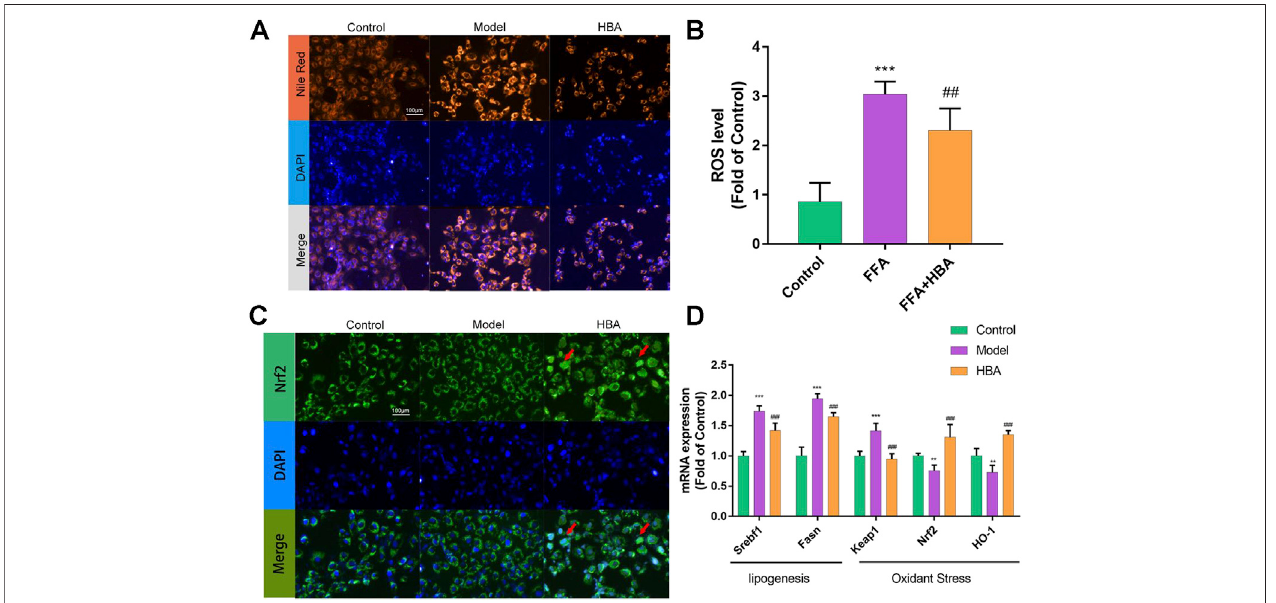
FIGURE5| TheeffectofHBAonFFA-inducedBRL-3Acell invitro (A) NileredstainingofBRL-3Acellsafter1 mmFFAwithandwithoutHBA(20 μ M)treatmenttoreveallipid level. (B) Measurement of ROS level in BRL-3A cells after 1 mm FFA with and without HBA (20 μ M) treatment. (C) Fluorescence image of FITC-conjugated secondary antibody stainingindicatesthelocationofNrf2(green),DAPIstainingindicatesthelocationofthenucleus(blue),andthemergedimagesshowthenuclearlocationofNrf2protein.Redarrows showtheHBA-inducedtranslocationofNrf2tothenucleus. (D) mRNAexpressionpro fi leofHBAonFFAinducedBRL-3Acellrelatedtolipogenesisandoxidantstress.Bar indicate means ± SD. ** p < 0.01*** p < 0.001 represent compared with the control; ## p < 0.01, ### p < 0.001 represent compared with Model. p < 0.05 was considered as statistically signi fi cant calculated by One-way ANOVA followed by Tukey ’ s test ( n (cid:1) 3, n indicates the replicates of the